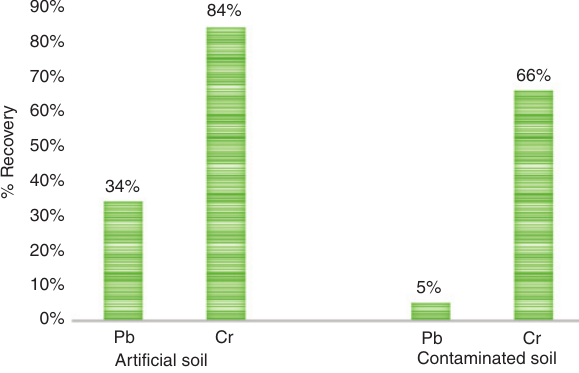
Figure 6: Overall recovery rates for soil samples calculated from the sum concentration of the 6 extraction steps compared to the recom- mended value for the total